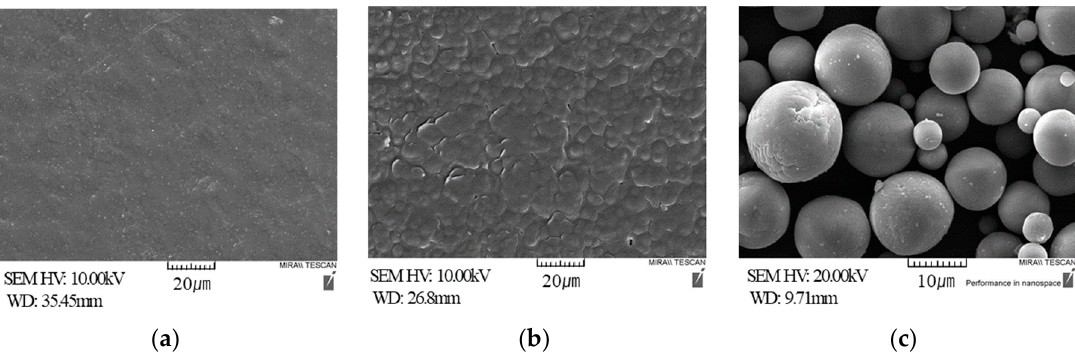
Figure 4. SEM images of raw materials ( a ) PBT; ( b ) PA6; ( c ) Al 2 O 3 .